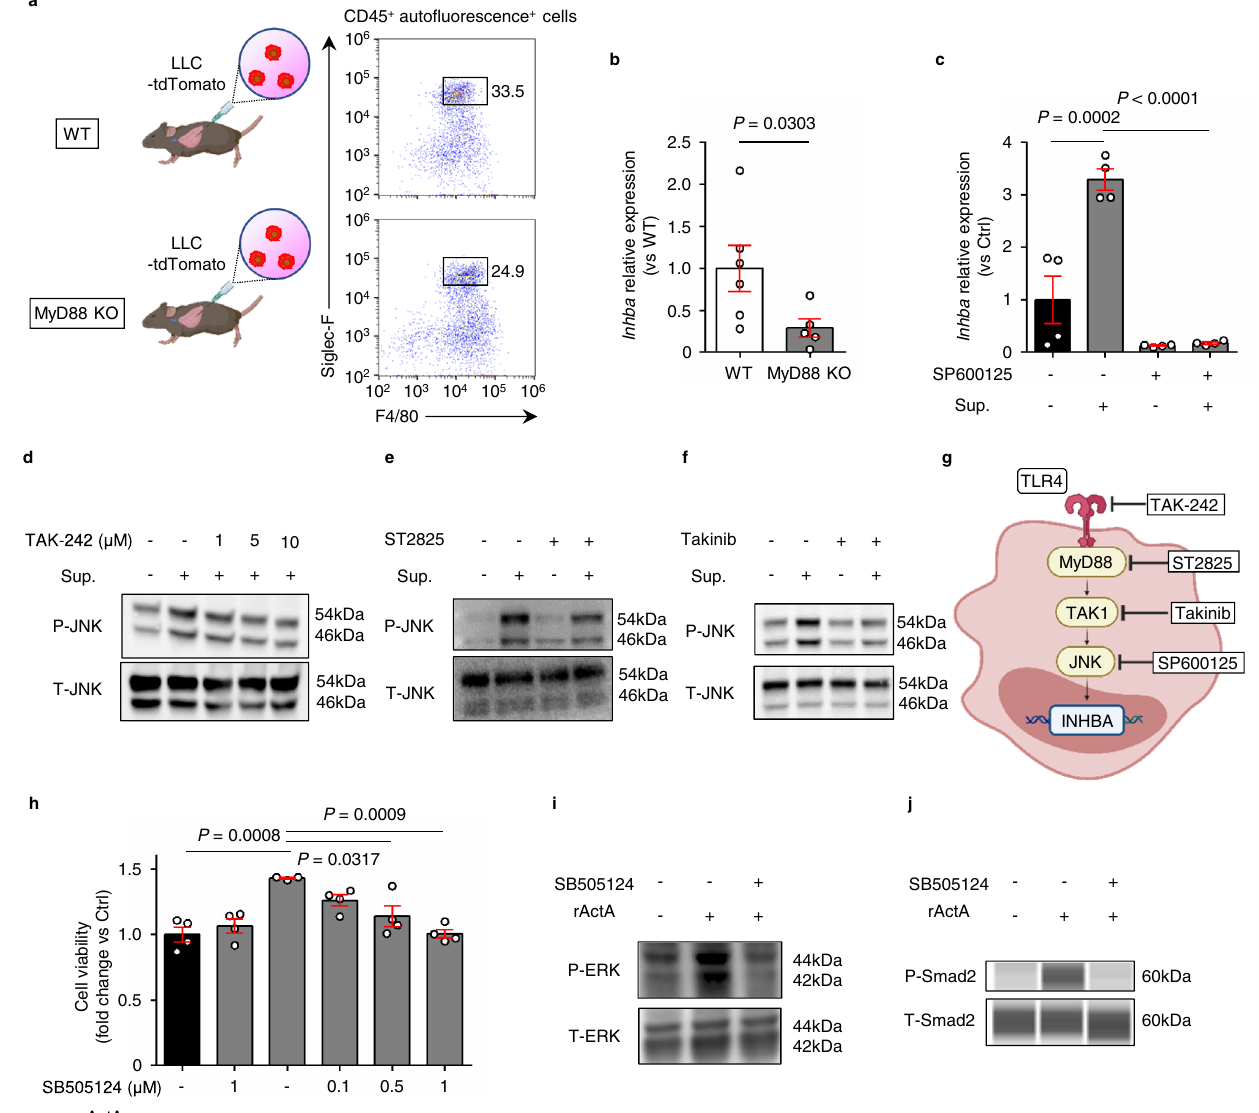
Fig.4|INHBAexpressioninalveolarmacrophages(AMs)isinducedviaMyD88- JNK dependent pathway. a Flow cytometry plots of AMs isolated from C57BL/6 wild-type (WT) mice and MyD88 knockout (KO) mice after inoculation with lung cancercells. b Inhba RT-PCRanalysis of AMisolatedfrom tumor-bearingwild-type mice and MyD88 knockout mice ( n =6 mice for wild-type, n =5 mice for MyD88 KO). c Inhba RT-PCR analysis in the AM cell line AMJ2-C11 after incubation with or without LLC cell line supernatant (Sup.) and JNK inhibitor SP600125 ( n =4 per group). d – f ImmunoblottingofJNKphosphorylationinAMcelllinewithorwithout stimulation of LLC cell line supernatant after incubation with each inhibitor ( d ; TAK-242, TLR4 inhibitor, e ; ST2825, MyD88 inhibitor, f ; takinib, TAK1 inhibitor). These images were representative of three independent experiments with similar